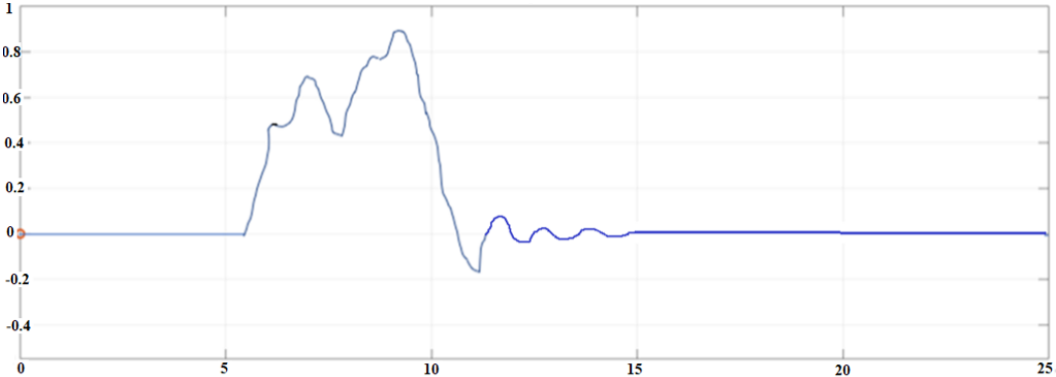
Figure 8. Passive actuation to elevate the structure of the vehicle when it meets a speed bump/hump. Although the goal was accomplished, there were undesirable ripples, and the motion of the chassis was abrupt.